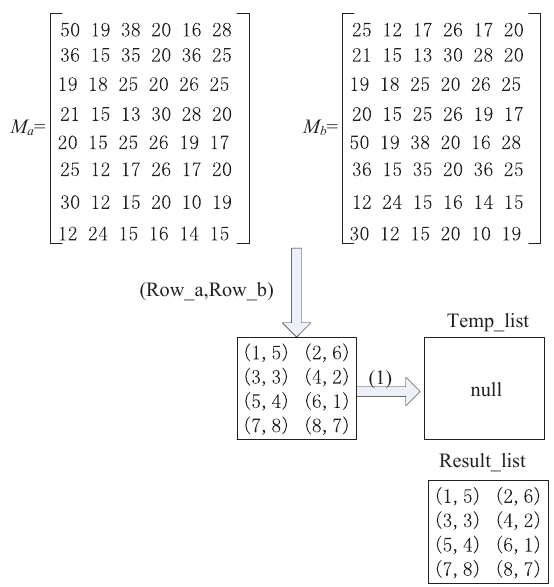
Figure 6. Example 1 for the Similarity by the Unit of Lines (SUL) method.